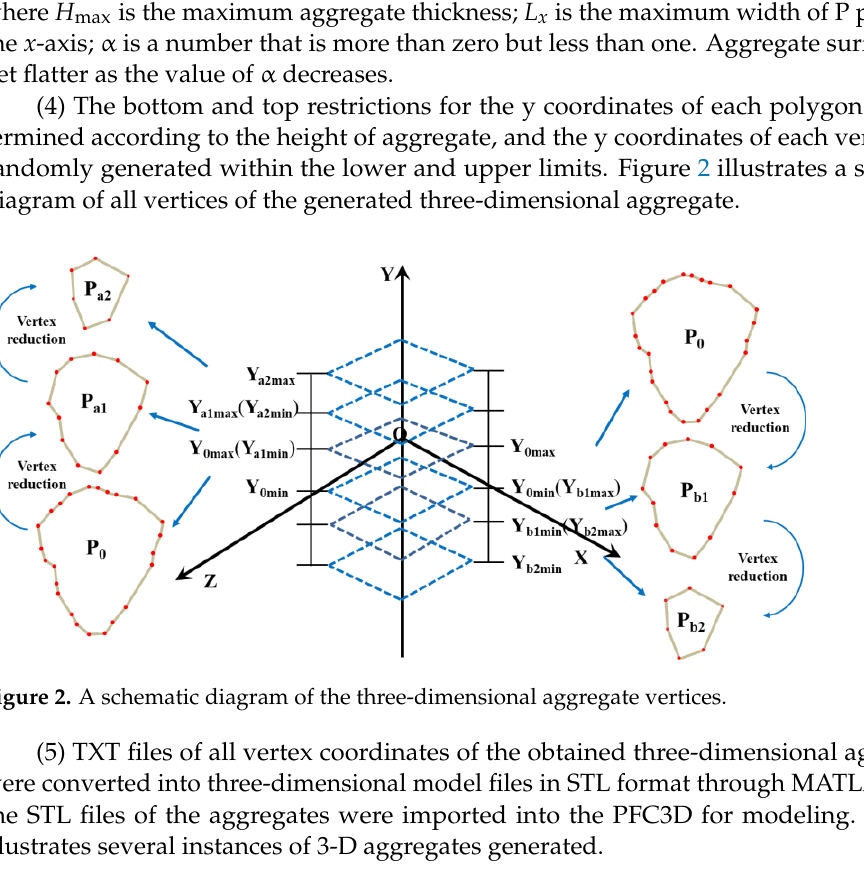
(3) For the sake of structural of three-dimensional aggregate, Equation (1) was used to estimate a maximum aggregate thickness in the direction of the y -axis.